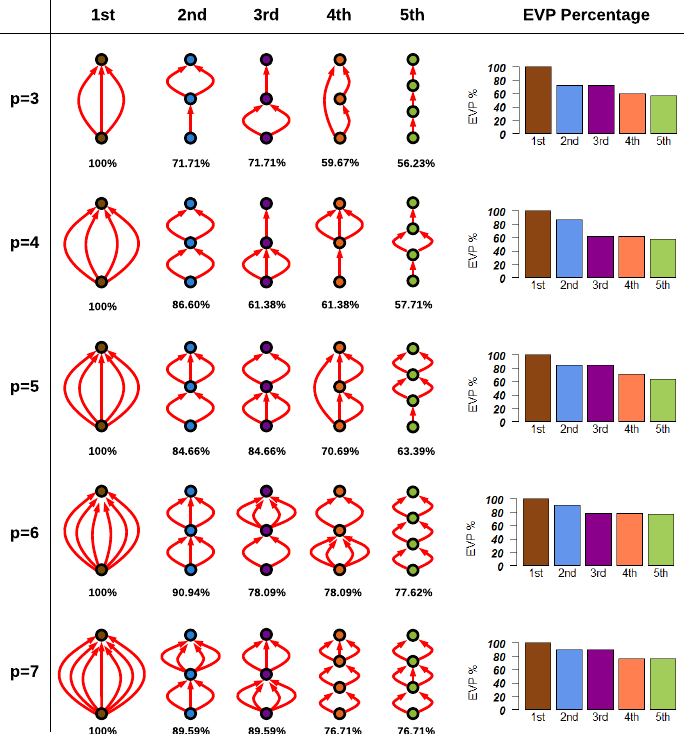
Figure 14. For a single working probability of x = 0.75, this table contains the top five configurations for every p ∈ [ 3,7 ] . The percentage below every graph shows the normalized EVP, and it is represented in the last column. Bars and graphs are in the same order, and the coloring of the vertices remarks this